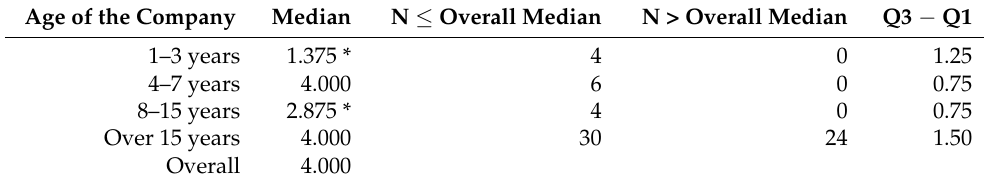
Table 10. Mood’s median test results: digitalization trends vs. age of the company.